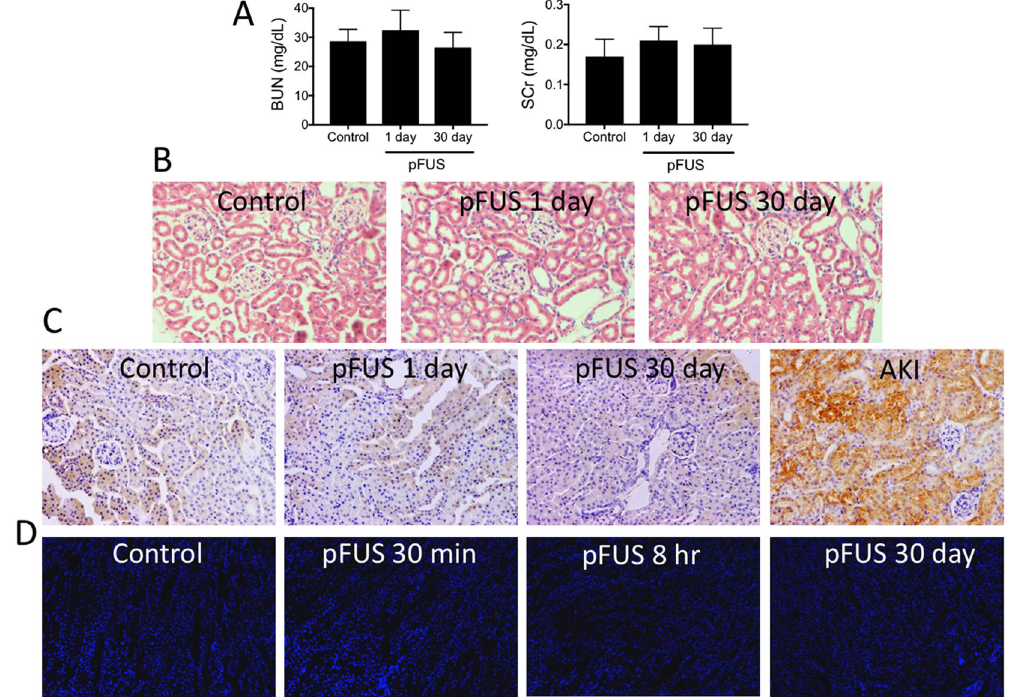
Figure 3. pFUS does not alter renal function, tissue architecture, or KIM1 expression at 1 or 30 days post- pFUS. ( A ) BUN and SCr values do not change between control mice (no pFUS) and mice at 1 or 30 days post- pFUS (p > 0.05; ANOVA). ( B ) H&E staining reveals consistent renal architecture between untreated controls and treated mice at 1 or 30 days. ( C ) Immunostaining for KIM1 demonstrates consistent expression between untreated controls and pFUS-treated kidneys at 1 or 30 days. For AKI positive control, kidneys were harvested 4 days after i.p. injection with cisplatin (15 mg/kg). The AKI kidney did not receive pFUS. ( D ) The appearance of TUNEL-positive cells in pFUS treated kidneys at 30 min, 8 hr, or 30 days post-pFUS was similar to unsonicated kidneys. Scale bars = 50 μ